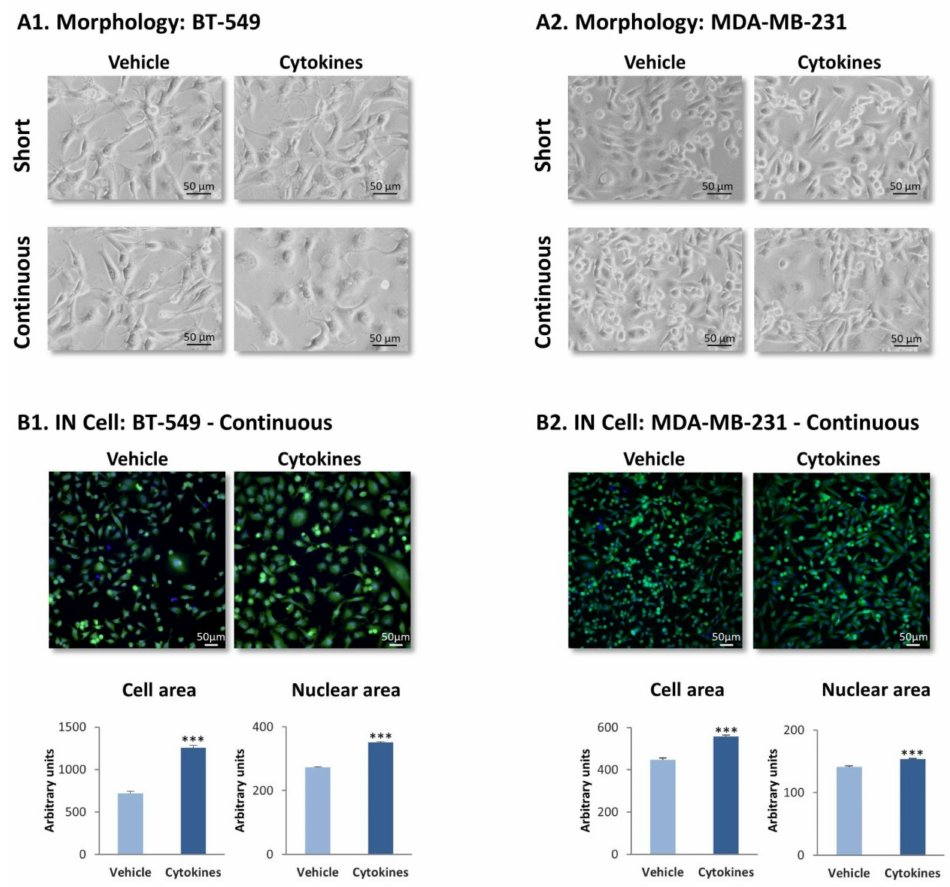
Figure 1. Continuous TNF α + IL-1 β stimulation leads to morphology changes in TNBC cells. TNF α (10 ng/mL) + IL-1 β (0.4 ng/mL) were used to continuously stimulate BT-549 and MDA- MBA-231 cells for ~6 weeks (“continuous” stimulation) or to stimulate the cells for 48 h (“short” stimulation); control cells were treated for the same time periods by the vehicle of the cytokines. Cytokine concentrations were selected based on the considerations described in the materials and methods section. ( A ) Tumor cell morphology determined by light microscopy. ( A1 ) BT-549 cells. ( A2 ) MDA-MB-231 cells. Phase-contrast images from a representative experiment of n > 3 are presented. Bar, 50 µ m. ( B ) Determination of cell morphology (images), cell area and nuclear area by the IN Cell technology, using calcein (green) and Hoechst (blue) staining. ( B1 ) BT-549 cells. ( B2 ) MDA- MB-231 cells. Images of cell morphology are accompanied by quantification of cell characteristics by the IN Cell technology. Bar, 50 µ m. The results of a representative experiment of n = 3 are presented. *** p <